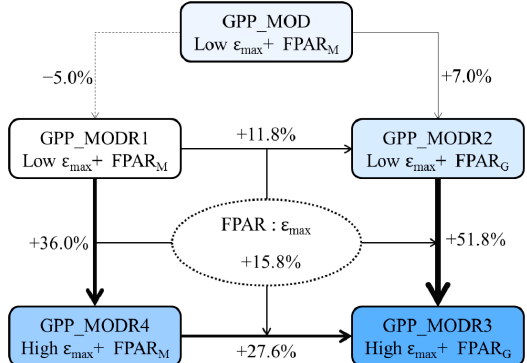
Figure 6. Performances of gross primary production (GPP) estimation models based on the MOD17A2 algorithm compared to in situ flux tower GPP (GPP_EC). The parameterization schemes of these models are showed in Table 1. The positive percentages indicate the improvement of relative predictive error (RPE) between MODIS-based daily GPP estimations and GPP_EC and vice versa. The solid arrows represent algorithm improvements while dashed arrows represent algorithm deterioration. Both the thickness of the arrow and the intensity of the color in model boxes, which are proportional to the percentages above, represent the degree of the model performances changes. The “Low ε max ” represents default ε max value for grassland in MODIS product, while the “High ε max ” represents the natural ε max estimations form ground measurements. The “FPAR: ε max ” in the central dashed ellipse shows the interaction of FPAR and ε max in GPP estimation models in this alpine swamp.